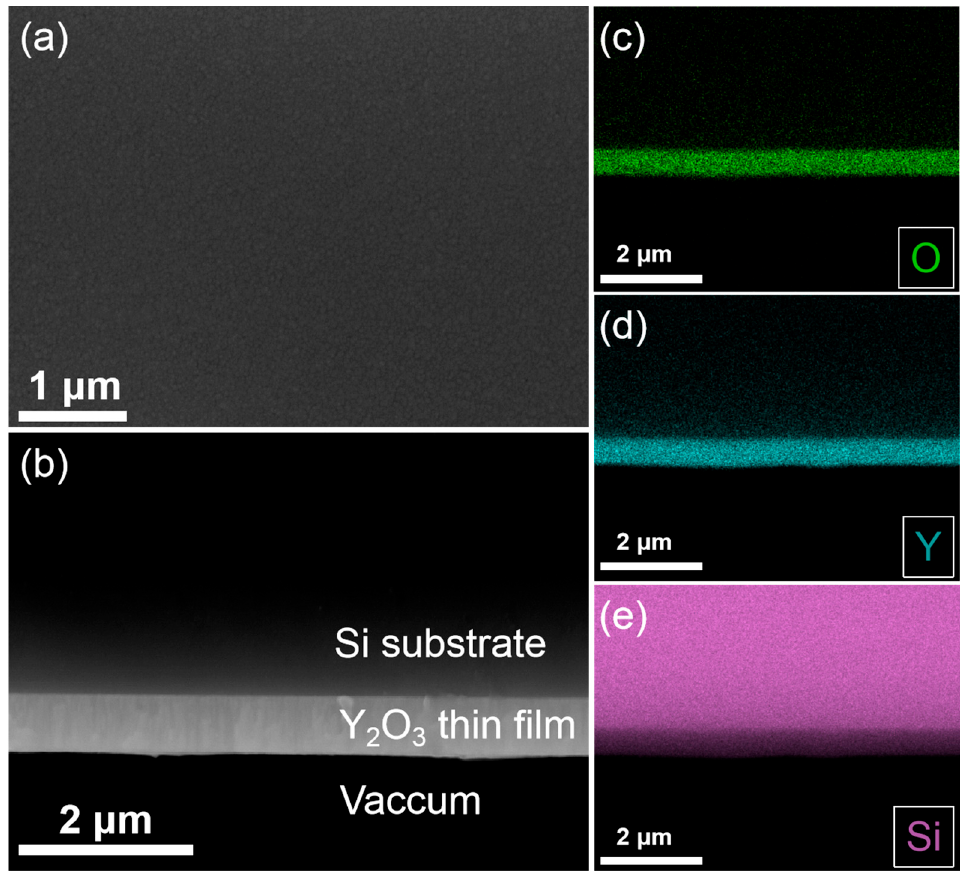
Figure 1. ( a ) and ( b ) are SEM images from the top and cross-section of the as-deposited Y 2 O 3 film (sample 1-3); ( c – e ) are the distribution of the O, Y, and Si elements from the EDS mapping results.